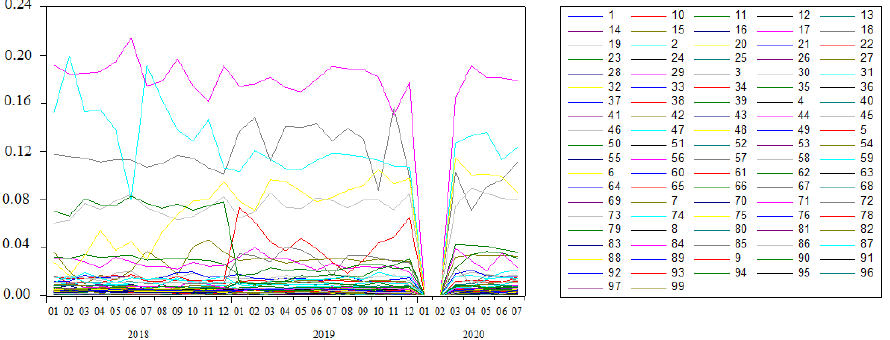
Figure 5. China import shares of the articles by year. Source: own investigation.